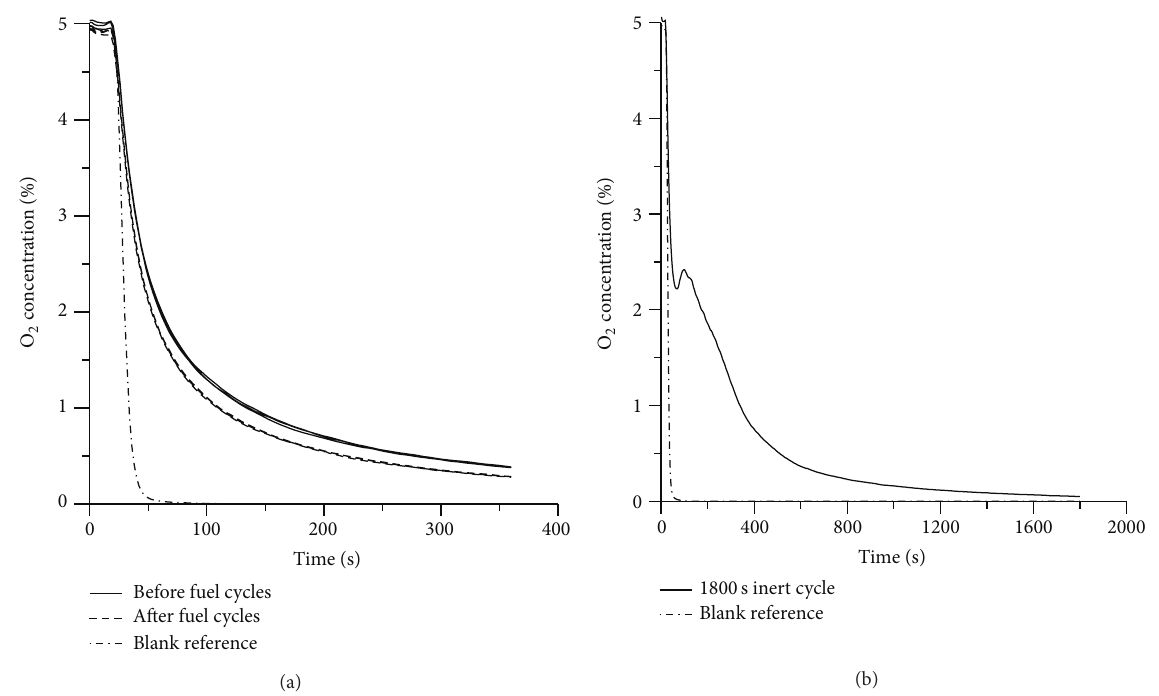
Figure 4: O 2 concentration profile in inert cycles. Tests were carried out on the 5.6% MgO 1300 sample. (a) inert cycles at 900 ∘ C; (b) 1800s inert cycle at 1000 ∘ C. For the experiments in Figure 4(a), three cycles were conducted before and following the fuel cycles. In Figure 4(b), the oxidation was performed at 900 ∘